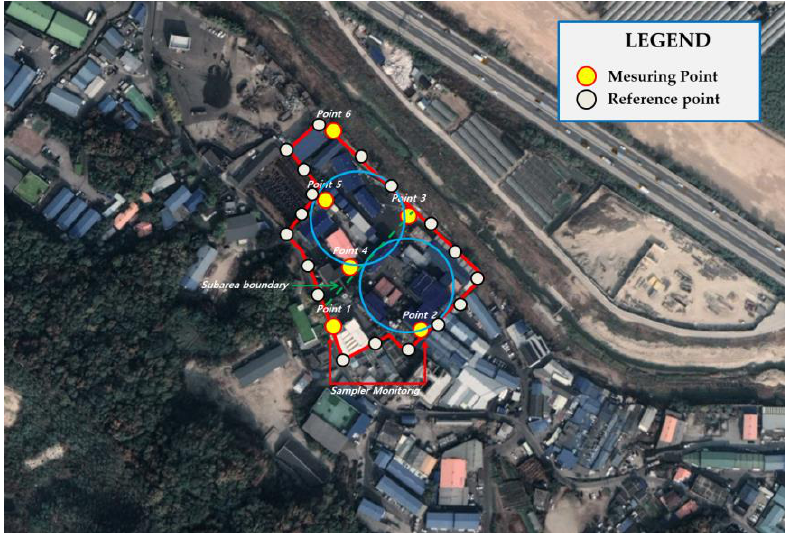
Figure 5. Measurement location of the site of study B.